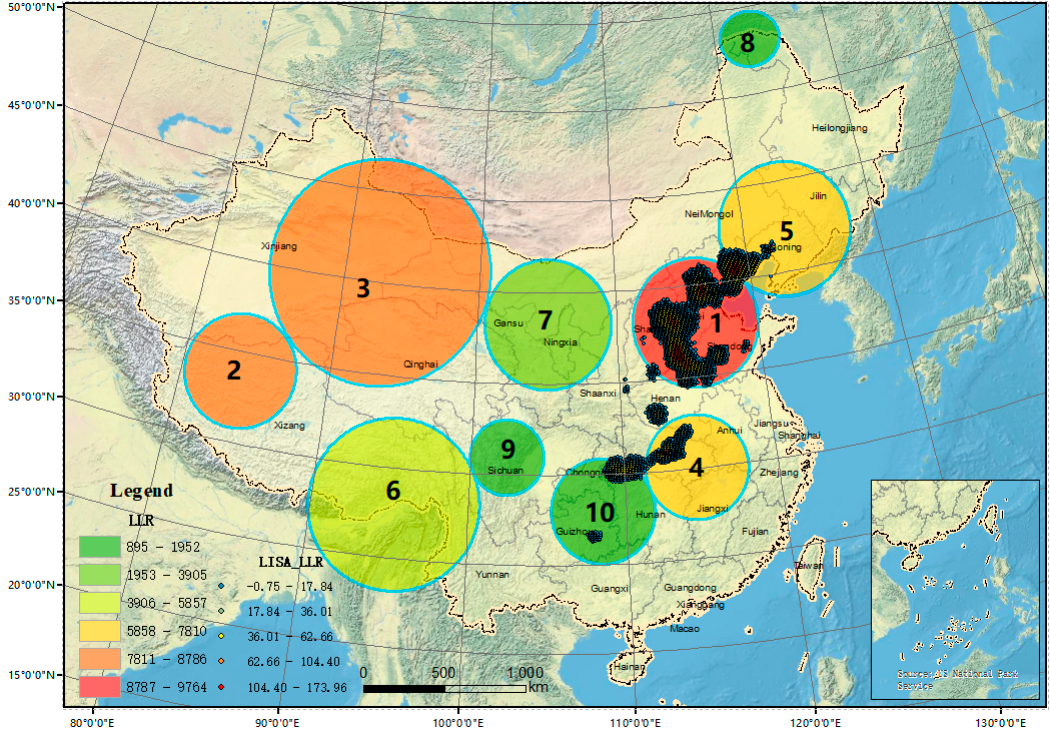
Figure 6. Overlap between the hig h– high value areas and the clusters of the STSM from 19 to 20 July 2016.